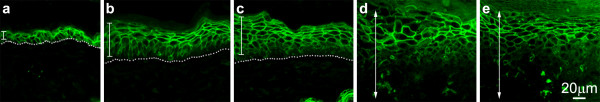
Changes in Cldn1 expression in skin tumorigenesis. In the normal (not shown) and vehicle-treated (a, after 12 weeks) epidermis, Cldn1 is localized in the basal and suprabasal layers; however in response to the two-stage chemical carcinogenesis protocol, the number of Cldn1-positive epithelial cells was progressively reduced starting from the basal layer and moving upwards at 2 (b), 4 (c), 8 (d) and 12 (e) weeks. Although a distinctly membranous Cldn1 association was maintained in the upper layers of the treated epidermis, as the number of Cldn1-negative epidermal cells in the lower epidermal layers increased, only sporadic Cldn1 localization was evident (c-e). The epidermal basal layer is indicated by a dotted line, and the suprabasal compartment is marked with a bracket (a-c); note that the basal layer is out of view in panels d and e; the entire view is therefore the suprabasal compartment and is marked with a double-ended arrow.